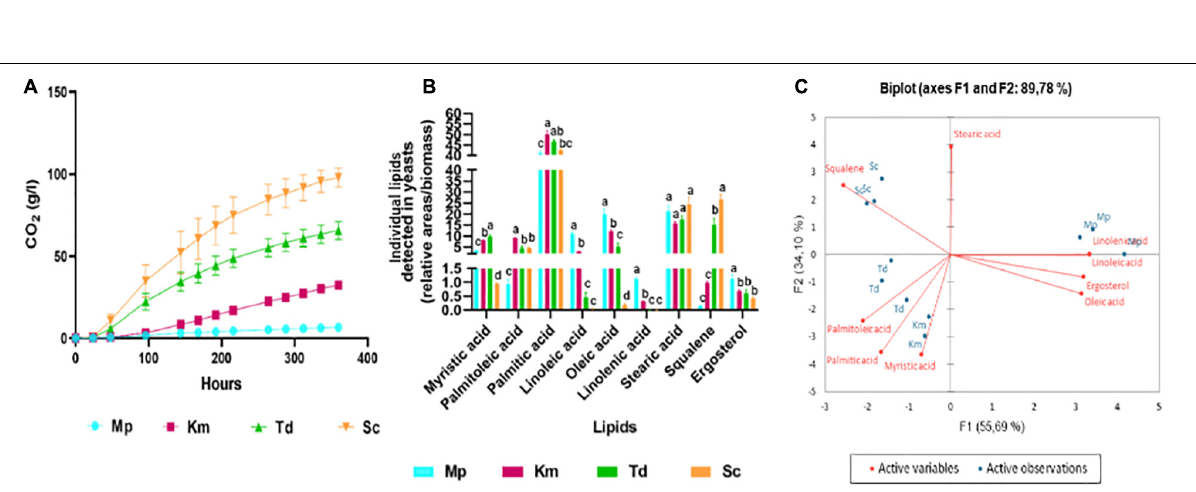
Frontiers in Microbiology |